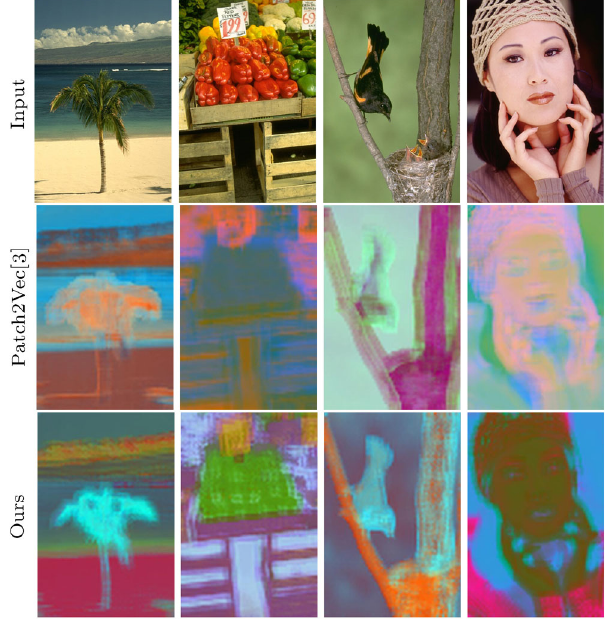
Fig. 6 Supervised vs. unsupervised embedding technique. Top: input images, from the training data of Ref. [3]. Middle: results of Patch2Vec [3]. Bottom: results of our unsupervised technique. Note that although our method did not train on these images, the textures are significantly less apparent in our embeddings. This suggests that segments with similar texture are embedded to closer locations in the embedding space.